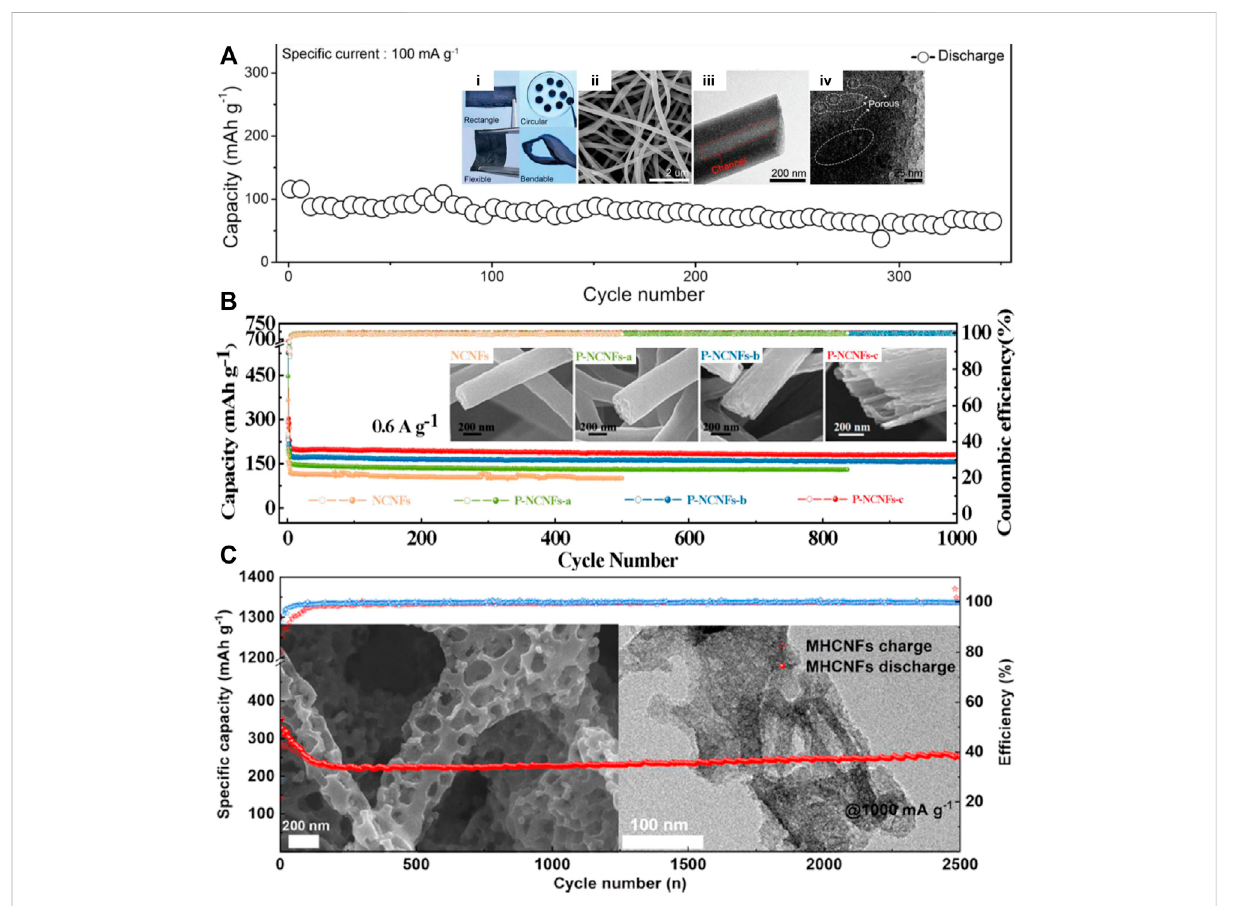
FIGURE 2 (A) Cycling stability of the potassium-based dual-ion batteries based on the hierarchically porous carbon fi bers anode at a speci fi c current of 100 mA g − 1 . (i) Opticalimagesofthehierarchicallyporouscarbon fi berstailoredintodifferentshapesandbendedtodifferentstates. (ii) SEMimageof the hierarchically porous carbon fi bers electrode. (iii) and (iv) Normal and enlarged TEM images of a single fi ber in the electrode (Zhang et al., 2019). (B) Cycling potassium ion storage performances of electrodes with different PMMA contents (a: 0.4 g; b 0.8 g; c 1.2 g) at a current density